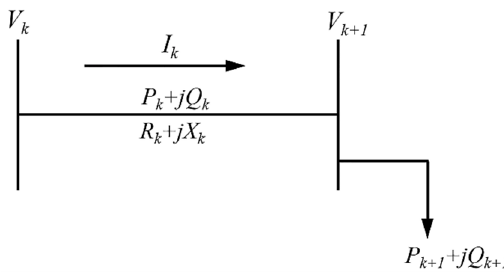
Figure 1. Single line of branch k of a radial distribution system.